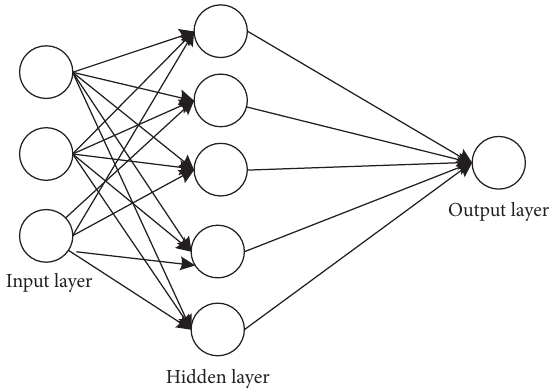
Figure 1: Structure diagram of neural